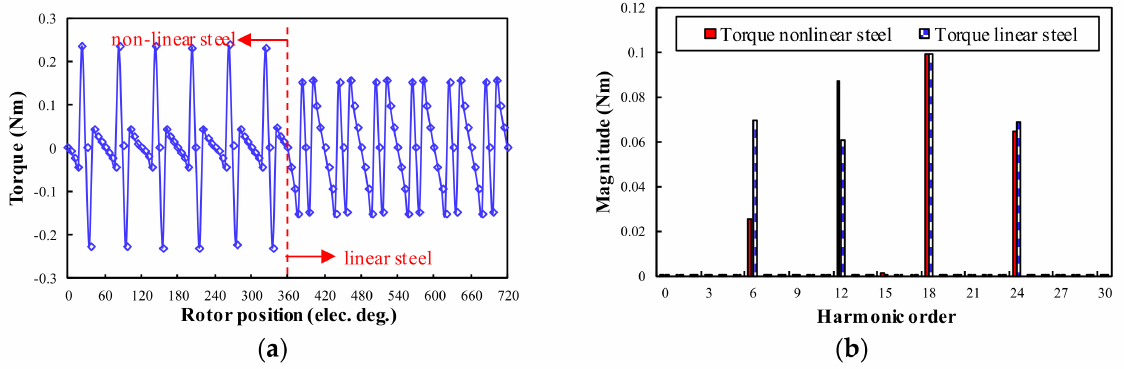
Figure 6. Cogging torque waveforms and Spectra for 24/4 WRSM, ( a ) Waveforms; ( b ) Spectra.